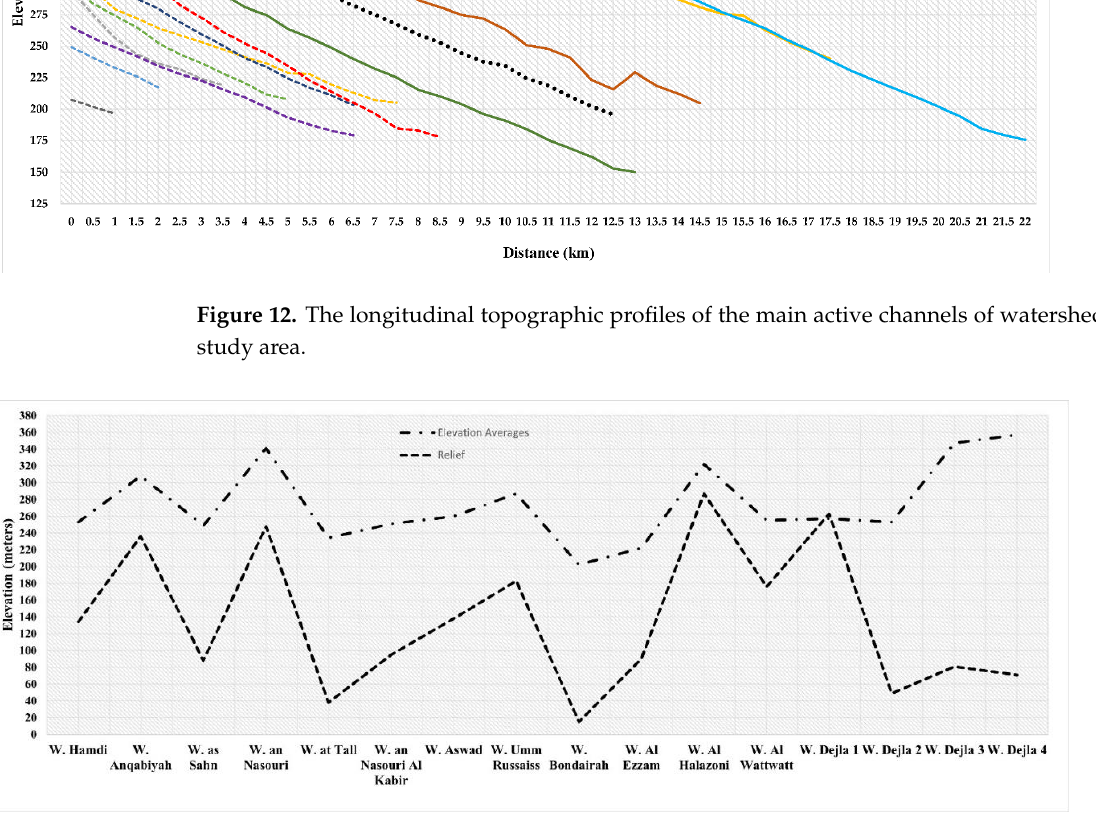
Figure 14. The aggression of urban spatial expansion against the valley floors as demonstrated by the comparison between CORONA and Landsat OLI images acquired in 1969 and 2020, respec- tively.